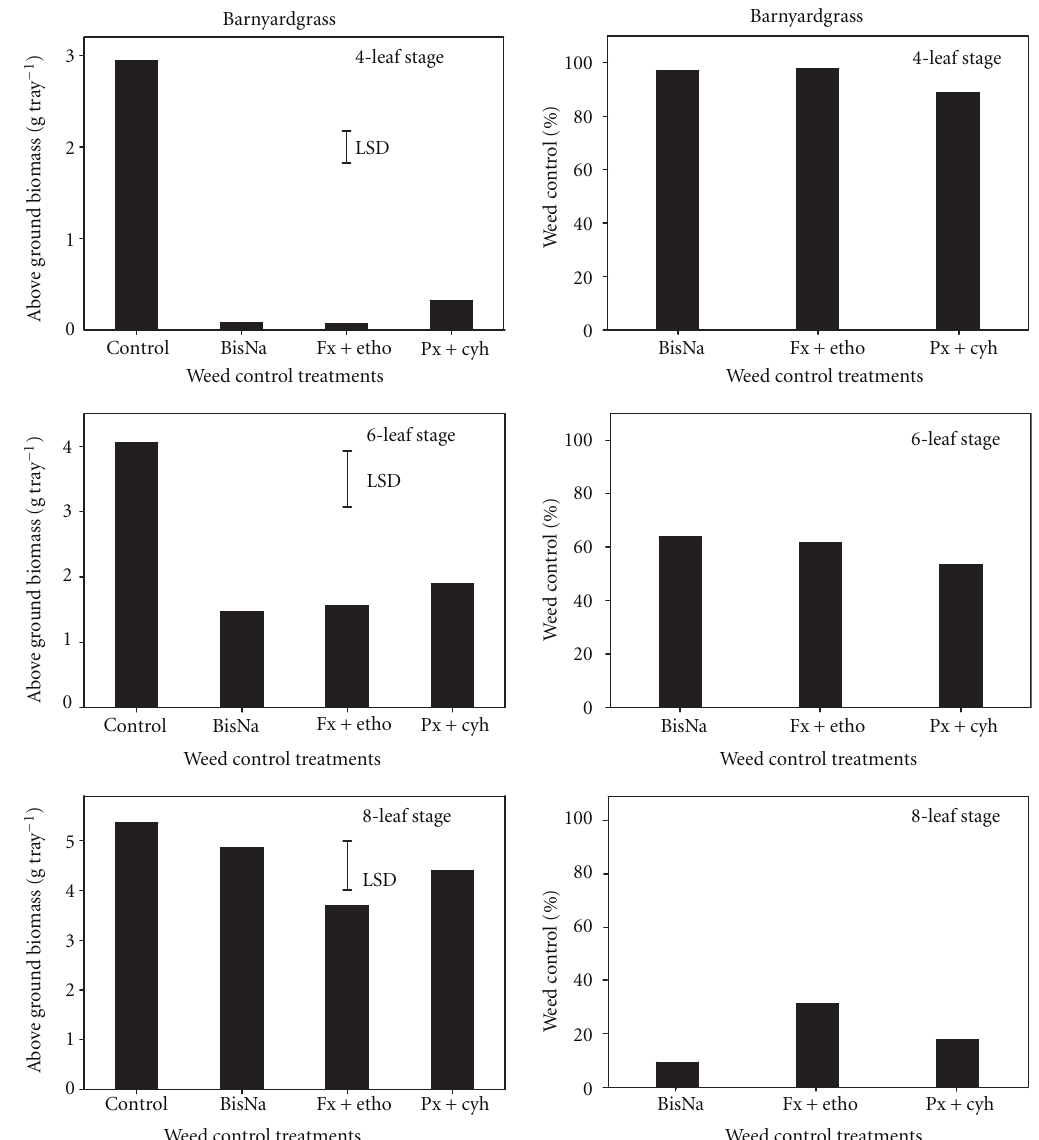
Figure 1: E ff ect of postemergence herbicides (BisNa, bispyribac-sodium; Fx + etho, fenoxaprop-p-ethyl + ethoxysulfuron; Px + cyh, penoxsulam + cyhalofop) on aboveground dry biomass (g) and control (%) of barnyardgrass when sprayed at its four-, six-, and eight- leaf stages. Mean comparisons were performed based on least significant di ff erence test at